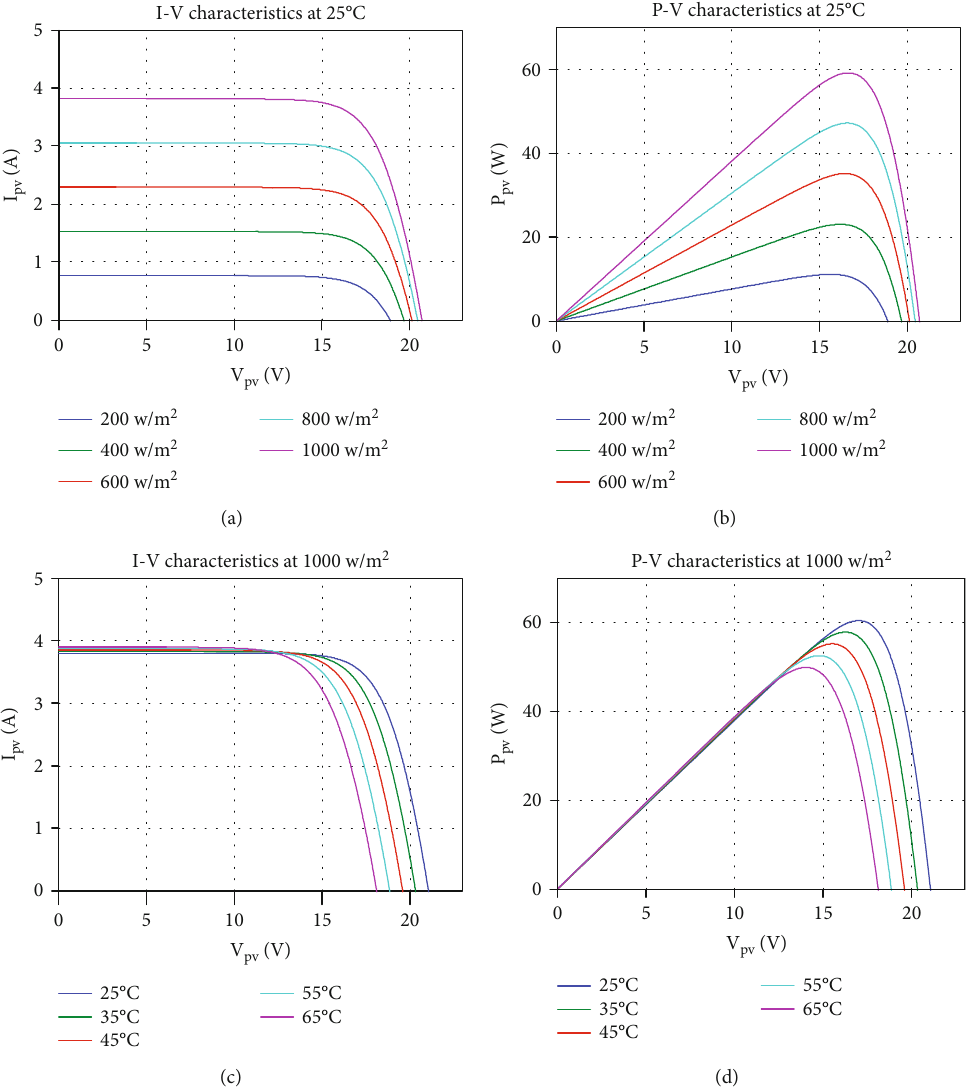
Figure 3: Current-voltage (a) and power-voltage characteristics (b) (case of constant temperature and variable irradiation) and current- voltage (c) and power-voltage characteristics (d) (case of constant irradiation and variable